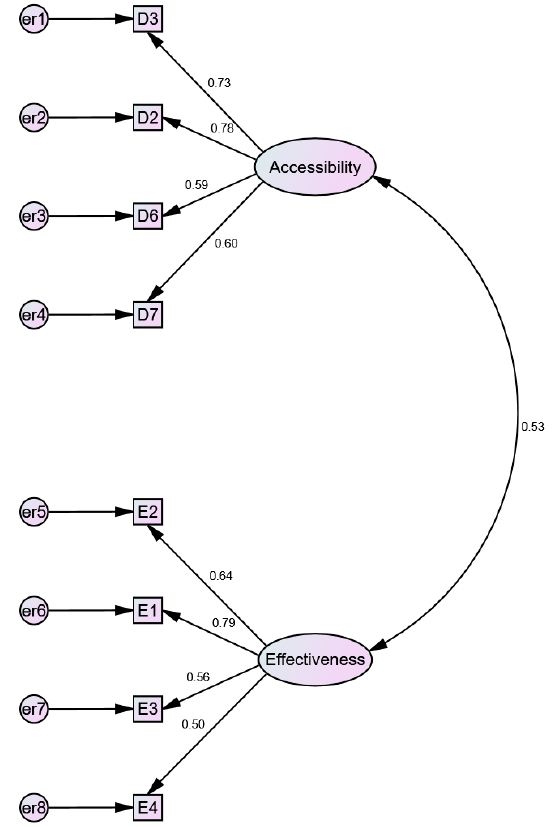
Figure 3. CFA model for the treatment effectiveness and the access to healthcare services during the COVID 19 pandemic (standardised estimates).